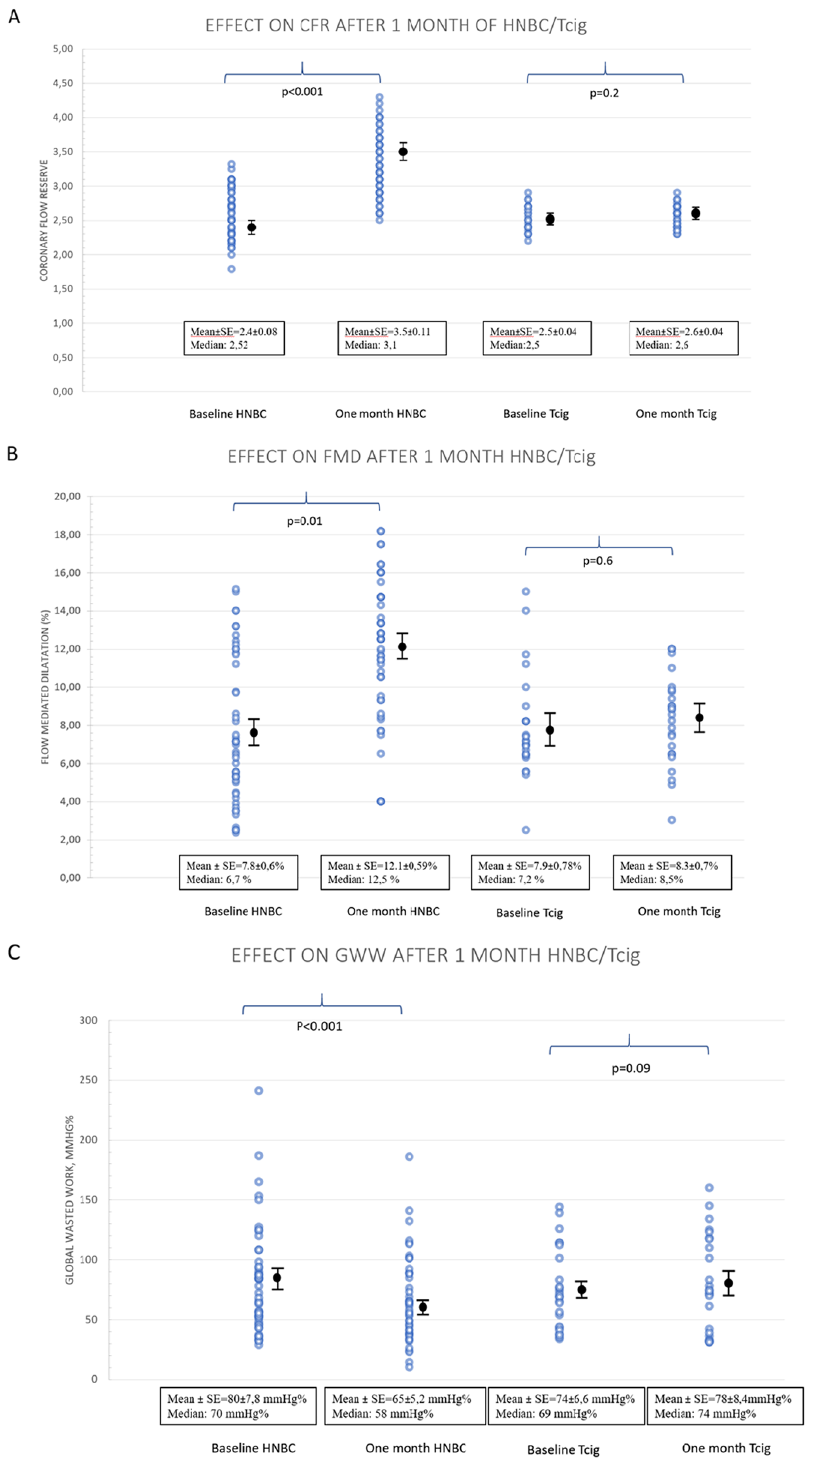
Figure 2. Progression of coronary flow reserve, flow mediated dilation, and myocardial work within 1 month of follow-up. Replacement of Tcig smoking with HNBC puffing for 1-month results in coronary and peripheral endothelial function improvement, along with wasted myocardial work reduction. CFR coronary flow reserve, FMD flow-mediated dilation, GWW global wasted work, SE Standard